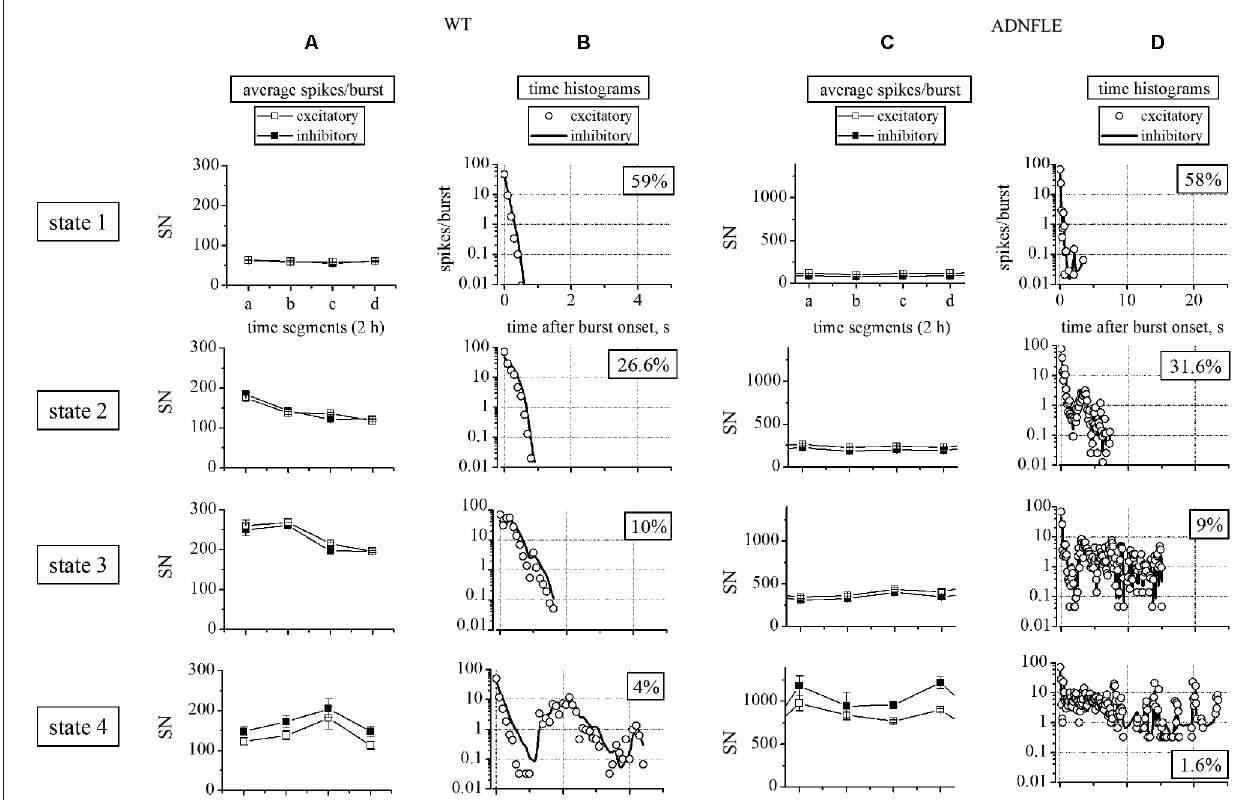
circles and continuous lines indicate, respectively, excitatory and inhibitory neurons. In the WT network we identified 69 unit (52 excitatory and 17 inhibitory). The number of identified up-states in the four 2 h segments were, respectively, 736, 755, 758 and 980. The average IBIs (inter burst intervals) were comprised between 8 and 10 s. In the Mutant network we identified 78 unit (63 excitatory and 15 inhibitory). The number of identified up-states in the four 2 h segments were, respectively, 422, 256, 299 and 282. The average IBIs were comprised between 22 and 26